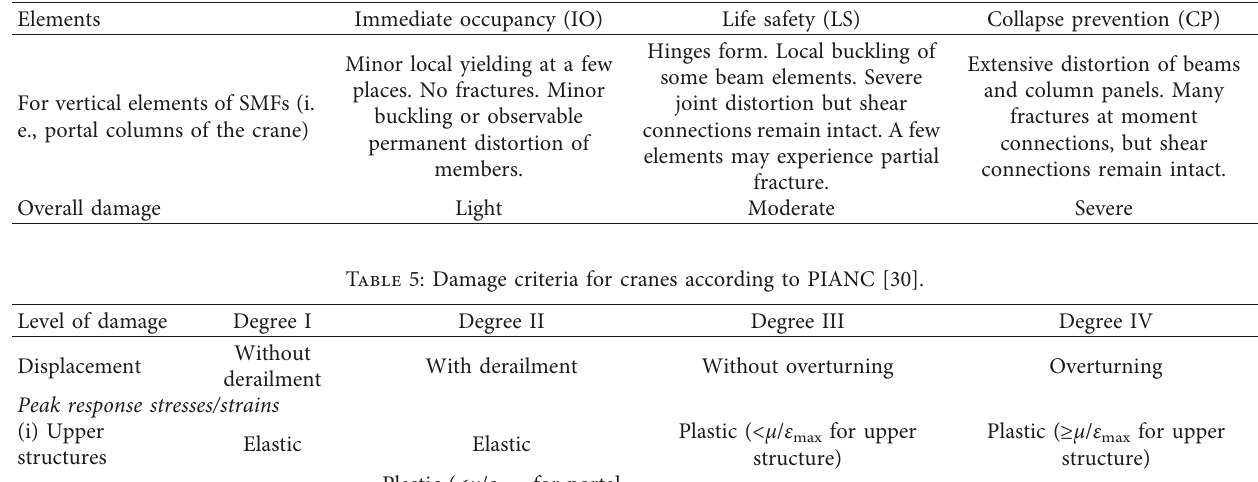
Table 4: Structural performance levels and damage based on ASCE/SEI 41-13 [3].